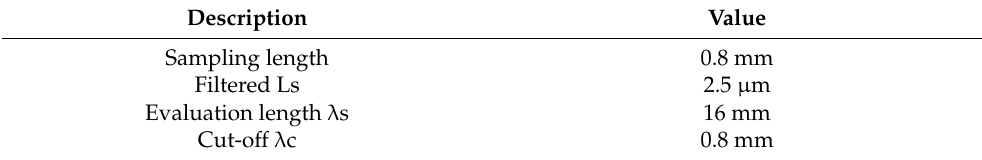
Table 3. Input parameters.